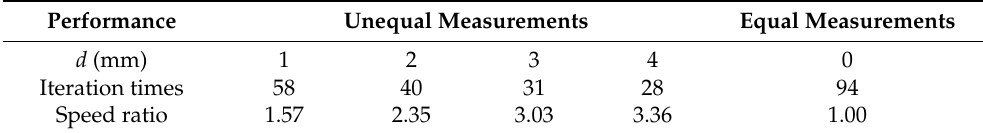
Table 1. Convergence speed ratio of the two